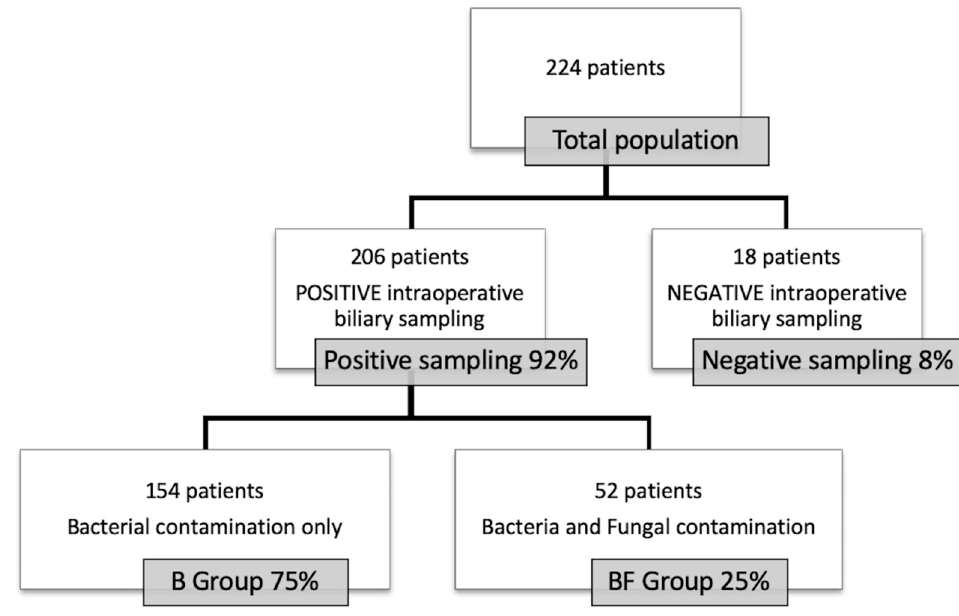
Figure 1. Study flowchart.